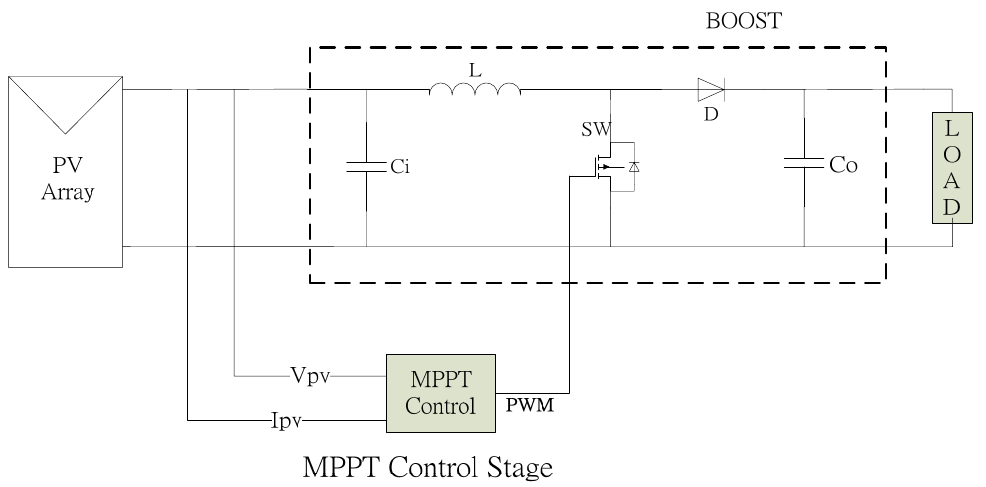
Figure 7. A system configuration.